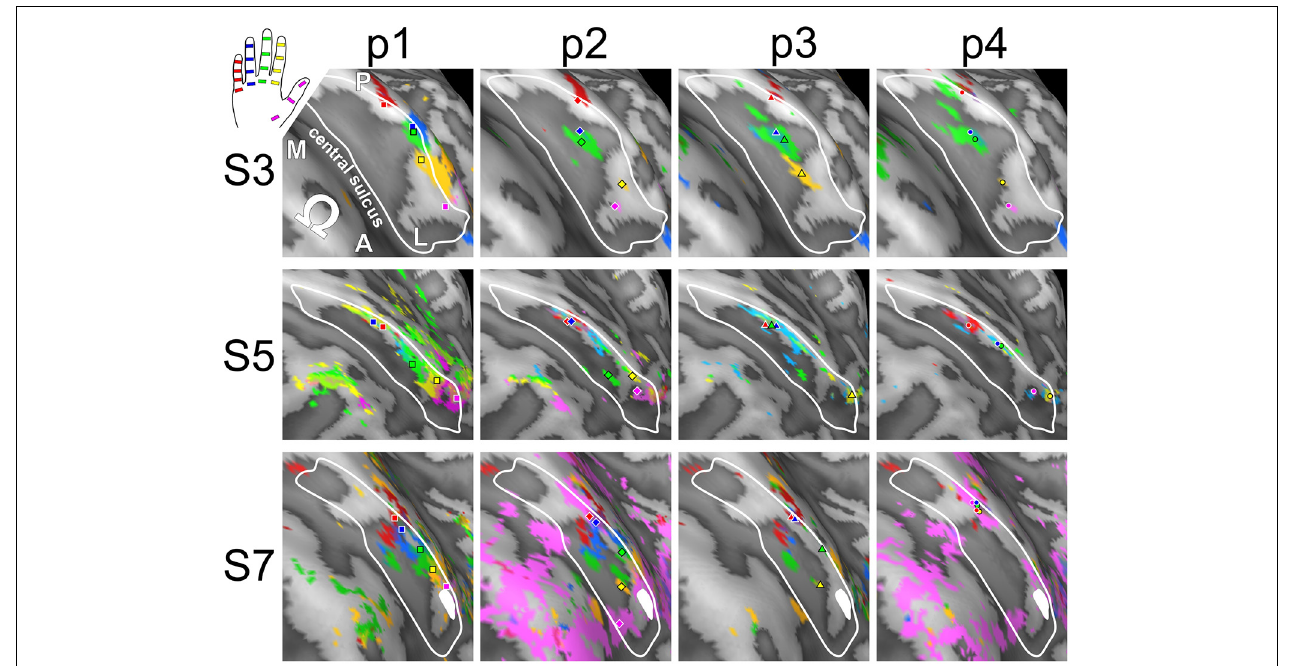
FIGURE 3 | Across-digit representations of phalanges and bases (subjects S3, S5, and S7). View from above onto the inflated surface reconstruction of individual left hemispheres with the motor hand knob ( (cid:2) ) in the foreground and the somatosensory BA 3b hand area in the center (convex areas, light gray; concave areas, dark gray; putative vessels, white;